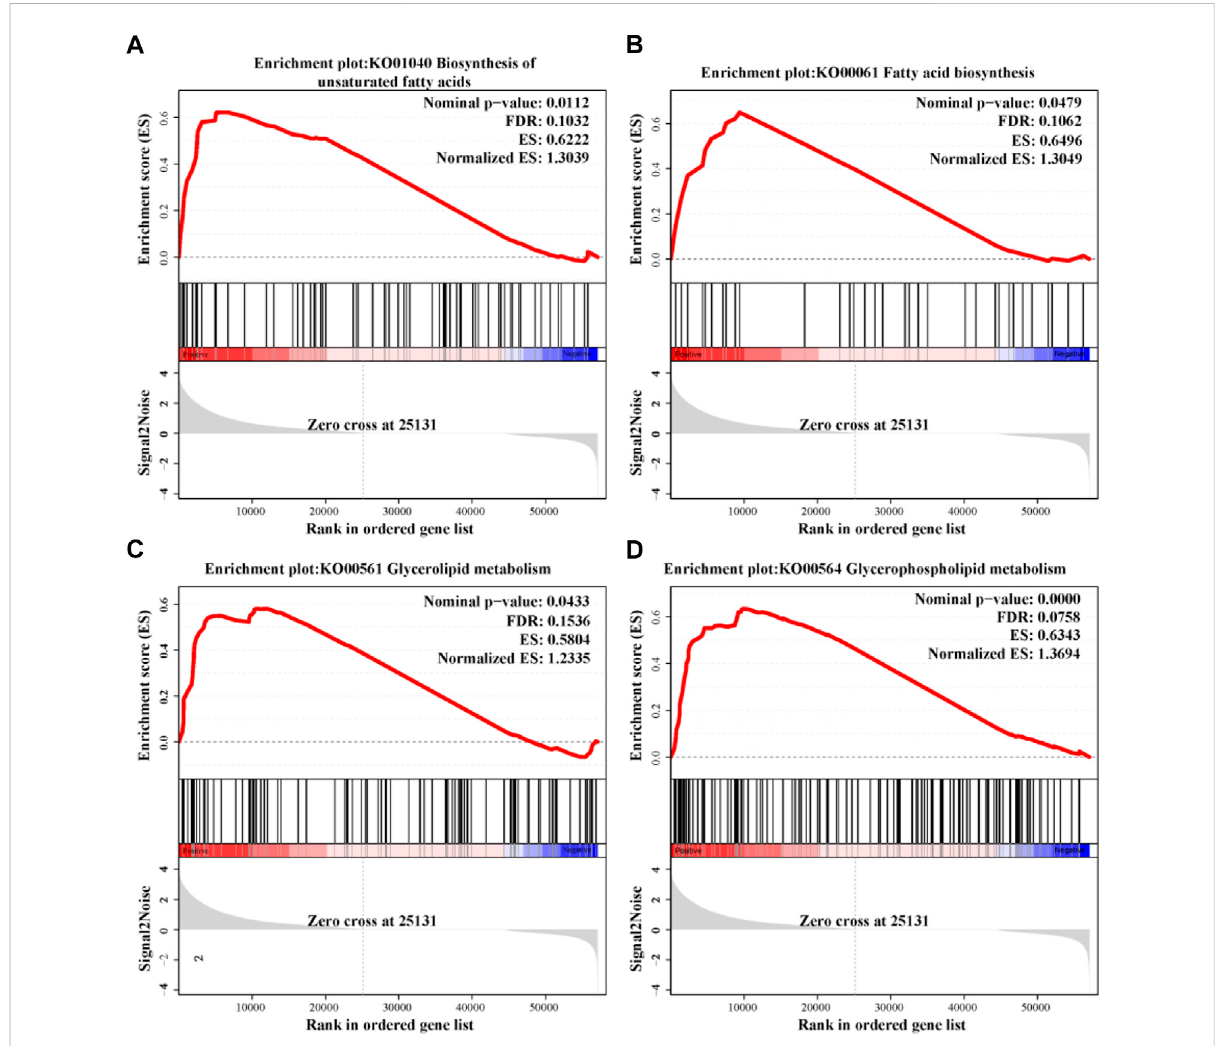
FIGURE 8 Changes in lipid metabolism pathways identi fi ed using GSEA in the hepatopancreas of C. quadricarinatus under two stocking densities (LD- vs-HD). (A) Biosynthesisofunsaturatedfattyacids. (B) Fatty acidbiosynthesis. (C) Glycerolipidmetabolism. (D) Glycerophospholipidmetabolism. The |Normalized ES| > 1, nominal p -value < 0.05 and FDR < 0.25 in each gene set were set as threshold values for statistical signi fi